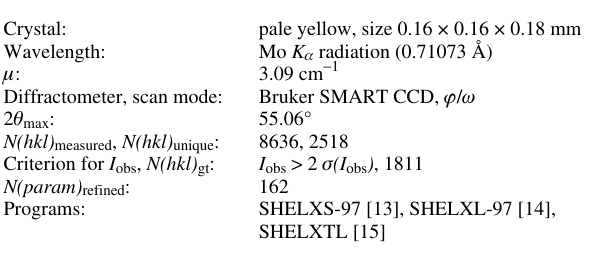
Table 1. Data collection and handling.